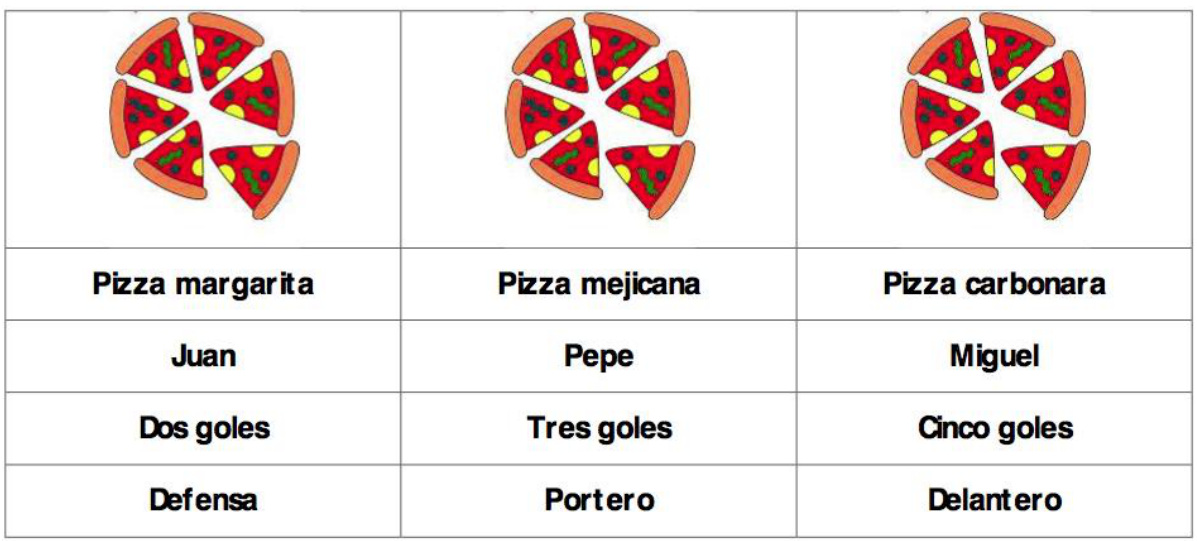
Figure 1. Example exercise used thus far in therapy